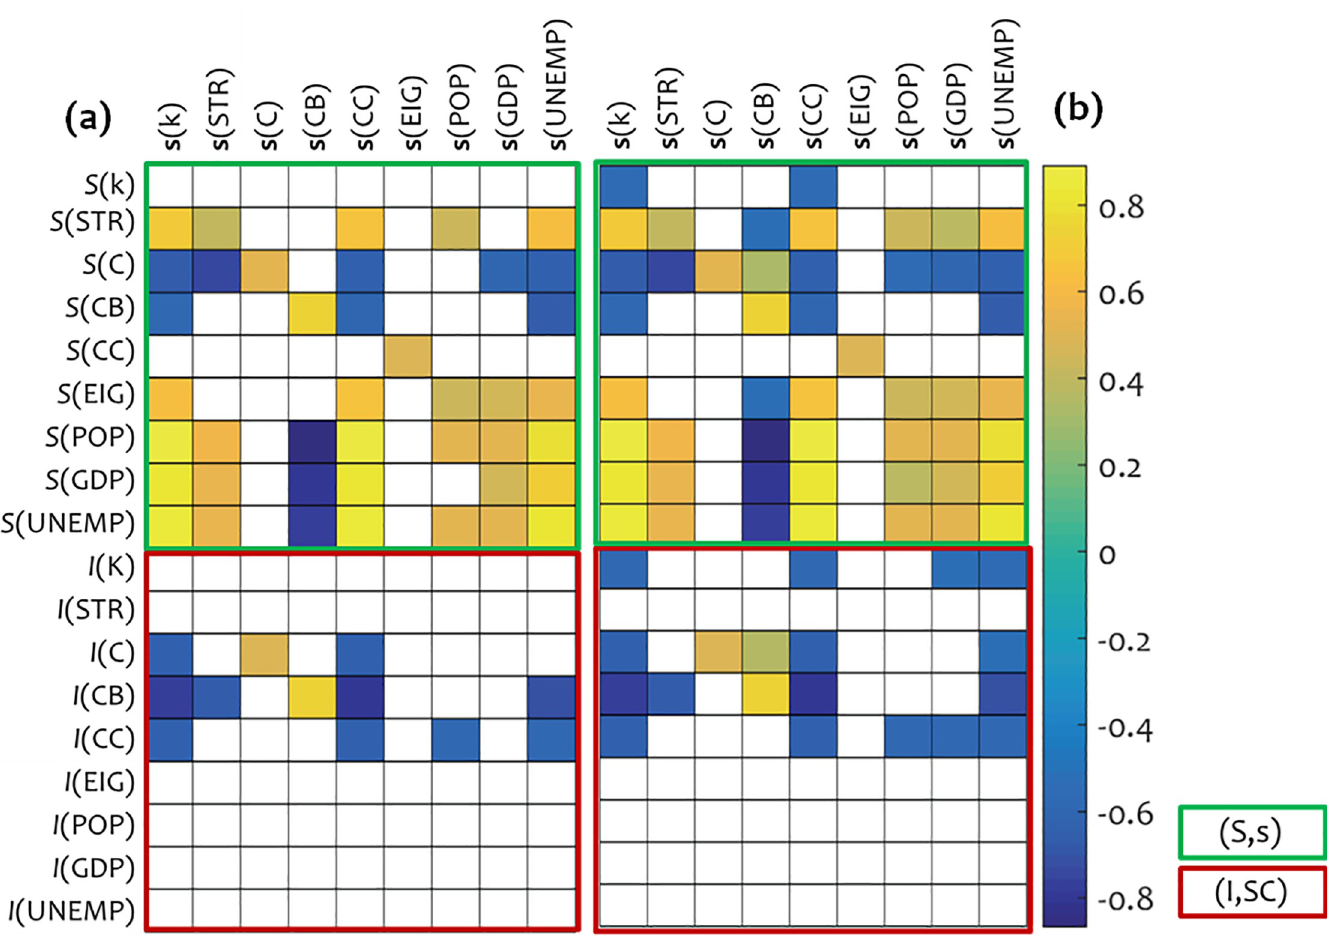
Fig 4. Spearman’s non-parametric correlations, (a) at 5% level of significance and (b) at 10% level of significance, between forces-alike f ( X ) and displacements-alike d ( X ) variables, stability S ( X ), and impact I ( X ). The s ( X ) variables were computed using the proposed formula (10), while S ( X ) and I ( X ) were computed using formulas (2) and (3), respectively. Symbols ( X ) represent attributes X 2 { k , STR, C, CB, CC, EIG, POP, GDP, UNEMP}, according to which each variable is computed. Only significant correlation coefficients are shown.